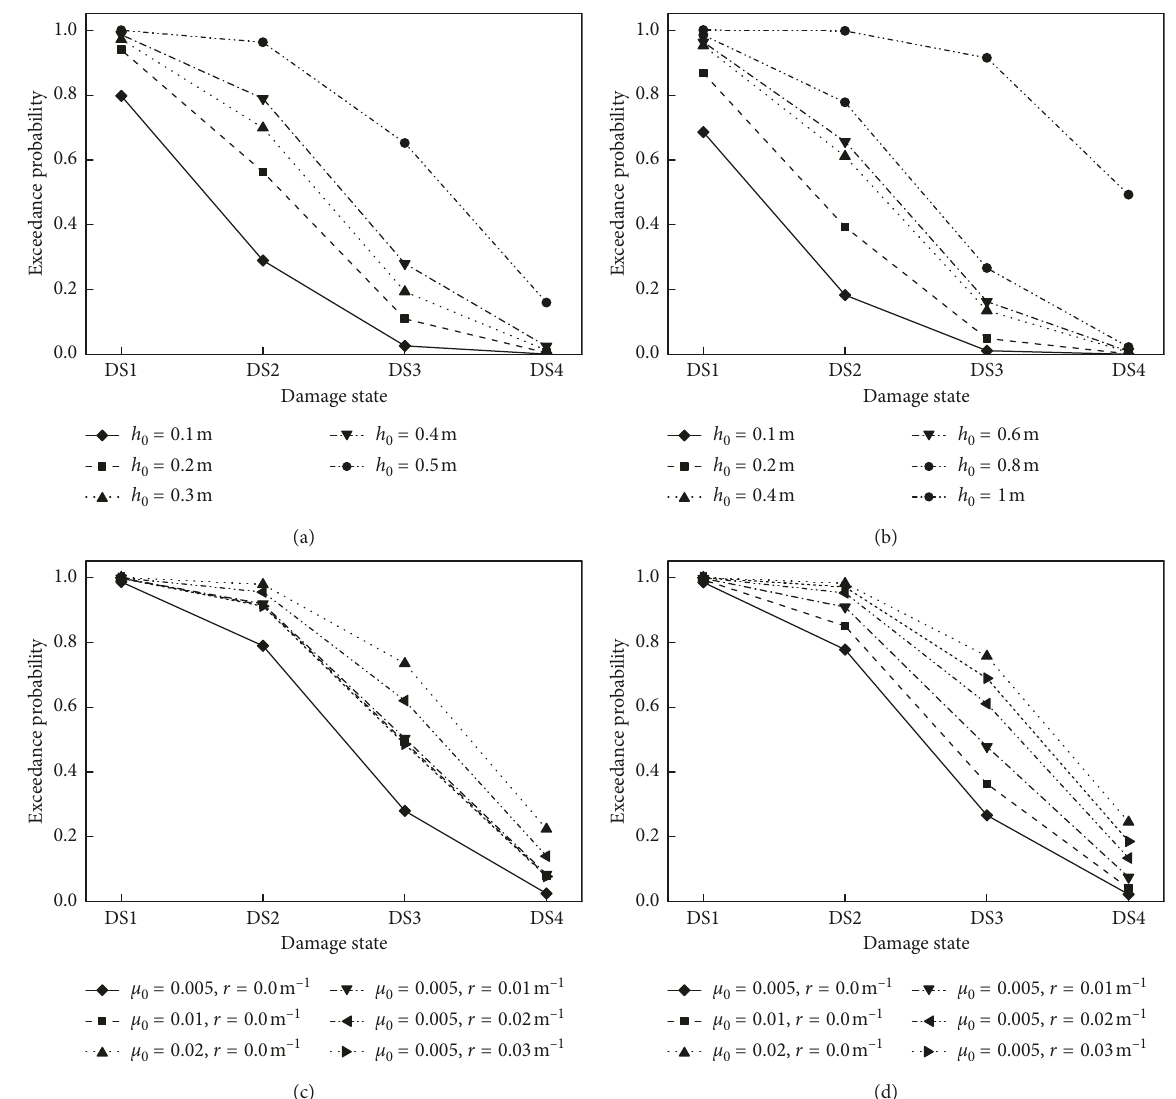
Figure 12: Structural residual displacement when K and DS4 are defined by the structural residual displacement in Table 2). (a) μ 0 . 0m. (c) h . 5m, h . 4m. (d) h h 1 (cid:31) 1 1 (cid:31) 0 0 (cid:31) 0